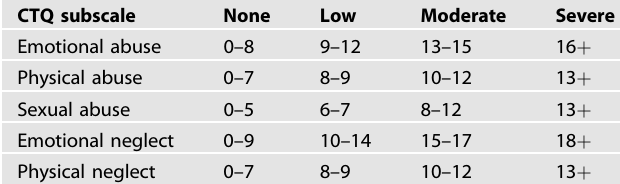
Table 1. Childhood Trauma Questionnaire by discrete categories